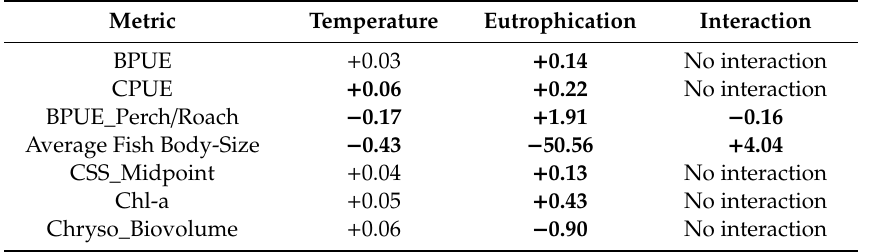
Table 4. Model coe ffi cient (positive + or negative − ) of pressure (temperature, eutrophication and interaction) for biological metrics selected. Bold: the impact of pressure or interaction on metric is